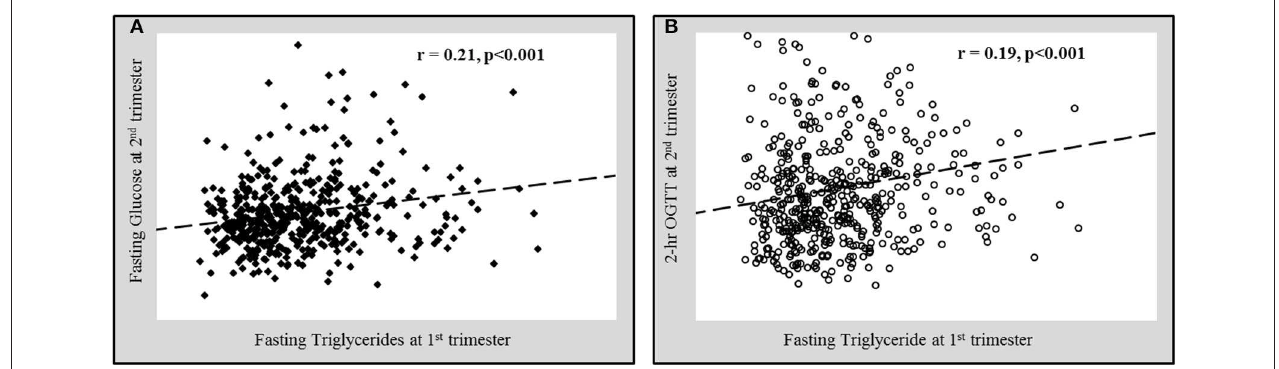
FIGURE 2 | Significant positive correlation of fasting triglycerides at 1 st trimester with (A) fasting glucose and (B) 2h oral glucose tolerance test values (OGTT) at 2 nd trimester.